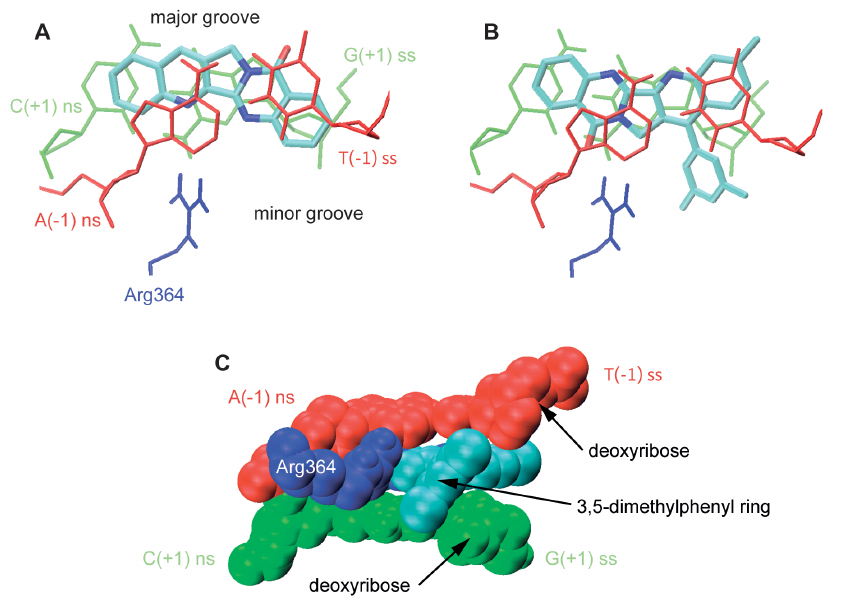
Figure 8. The two binding orientations of compounds 3. Docking studies revealed two different modes of binding: A . In the case of compounds 3a – e , the docking pose was similar to the one found for topotecan by X-Ray crystallography. B . Compounds 3f and 3g , on the other hand, changed their mode of binding in order to shield the highly hydrophobic dimethylphenyl moiety from the aqueous environment by burying it between the base pairs of the scissile strand and the surface of the protein. C Detail of the newly described binding feature of the human topoisomerase 1-DNA complex uncovered by our study.